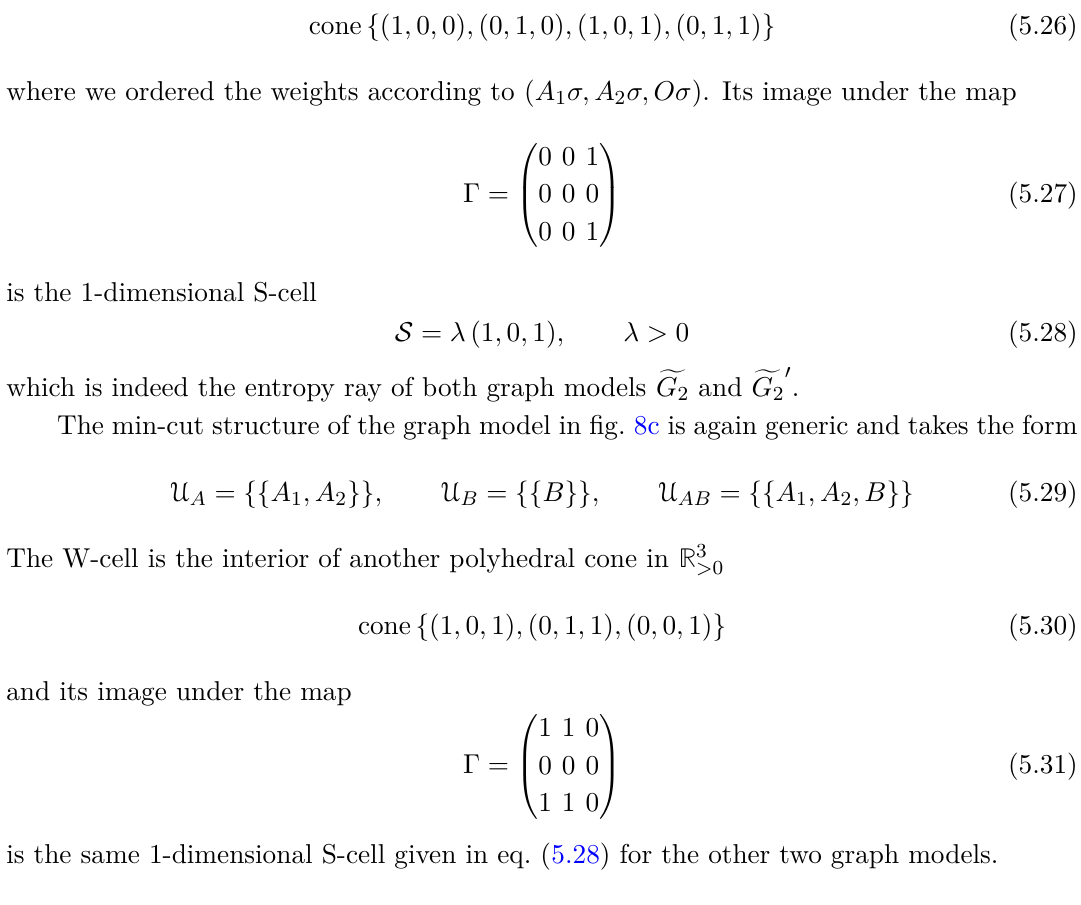
Figure 9. A cross section of R 3 section shows the partition of R 3 of the graphs in fig. 8, before and after the recoloring from eq. (5.32). See the main text for more